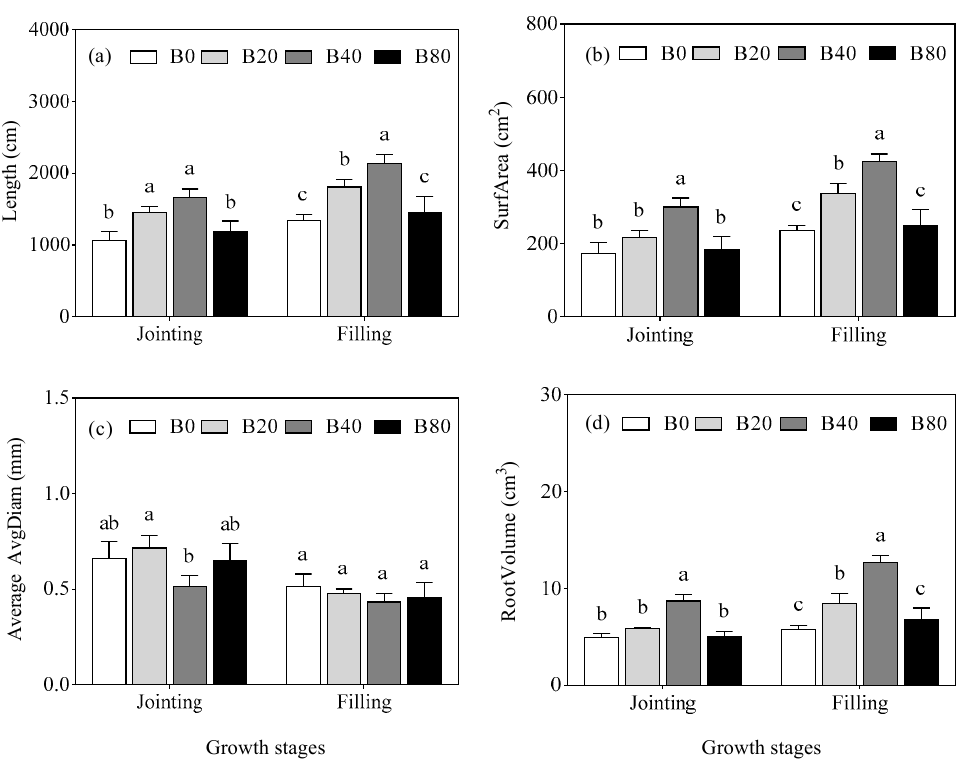
Figure 5. Effect of biochar on the growth of maize root. Note: Different letters indicate significant differences (one-way ANOVA, p < 0.05, Duncan analysis).